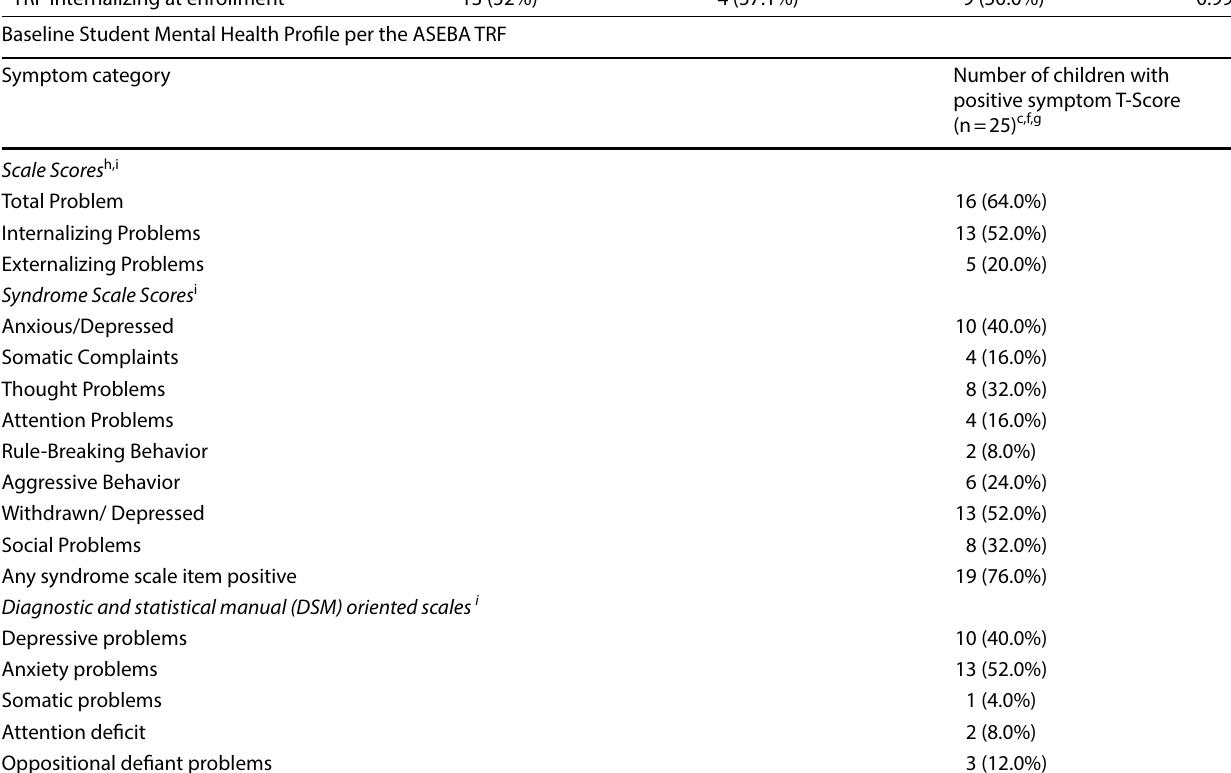
Comparison of children who did and did not complete a qualitative